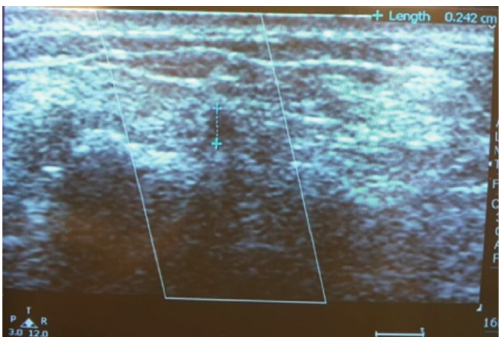
Figure 1: Ultrasound guided left distal radial arterial diameter